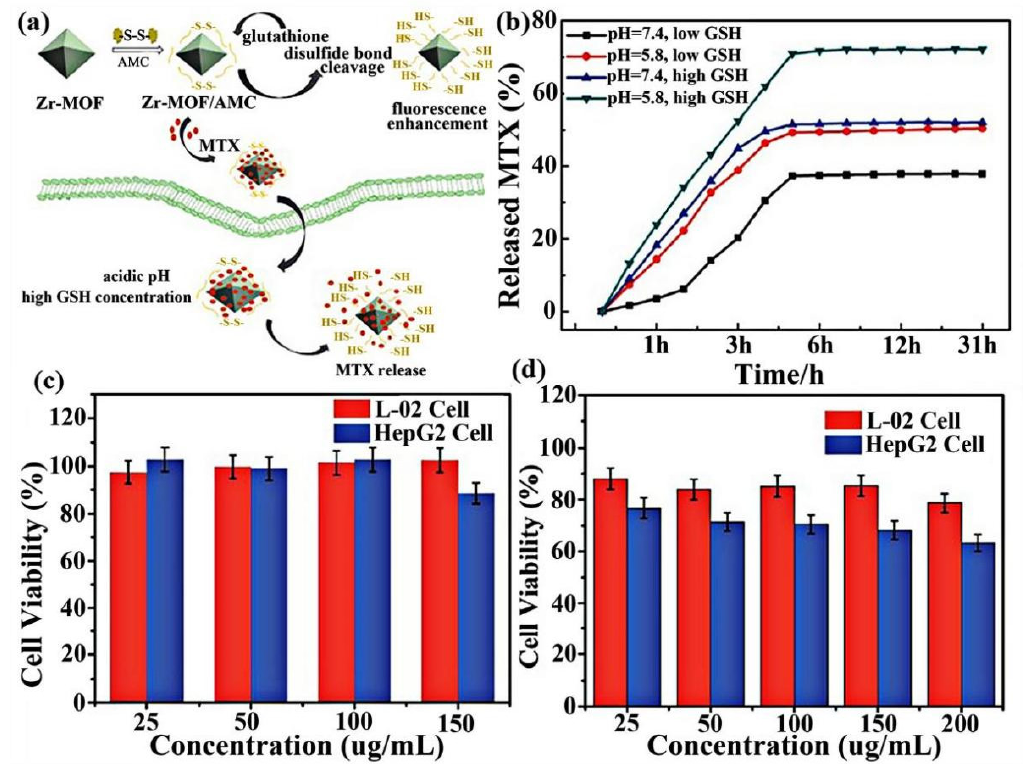
Figure 4. ( a ) The Zr-MOF/AMC/MTX nanocarrier and ( b ) its MTX release. Cell viability of ( c ) Zr-MOF/AMC and ( d ) Zr-MOF/AMC/MTX in L-02 and HepG2 cells. Reproduced with permission from Ref. [74], copyright (2020) Royal Society of Chemistry.